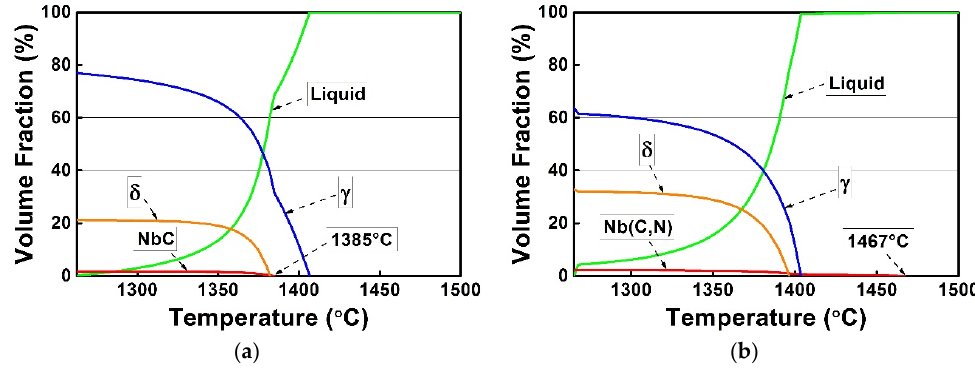
Figure 3. Phase diagrams of alloys ( a ) 4C0N and ( b ) 2C4N calculated by JMatPro software under the Scheil-Gulliver condition and plotted as a function of temperature.